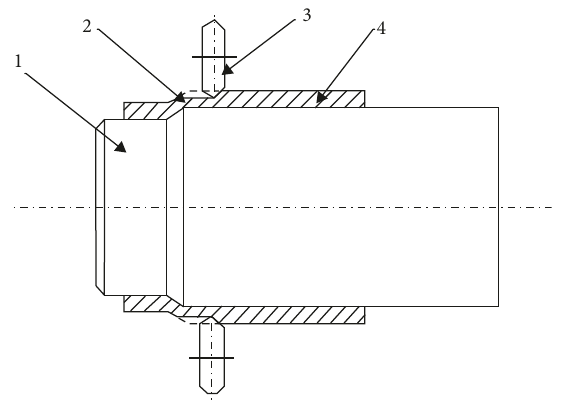
Figure 1: Spinning principle.